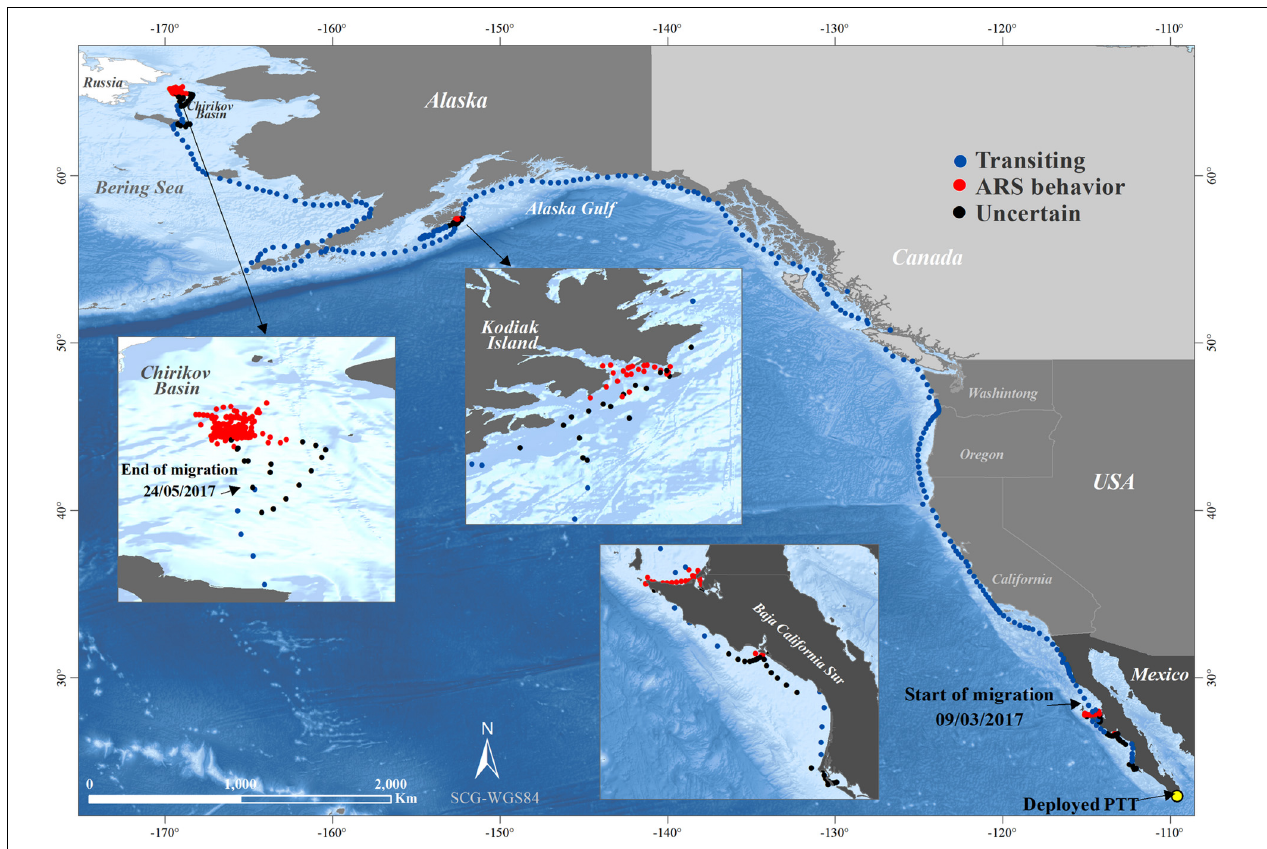
FIGURE 2 | Tracks of migration route of María, the single individual gray whale tagged on February 12 at San Jose del Cabo, BCS, Mexico 2017, showing its